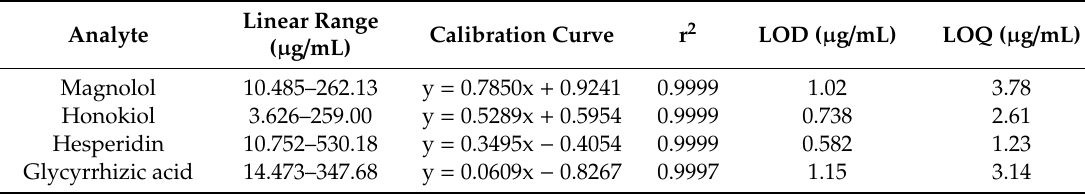
Table 1. Calibration curve, limit of detection (LOD) and limit of quantitation (LOQ) of four potential active ingredient markers ( n =